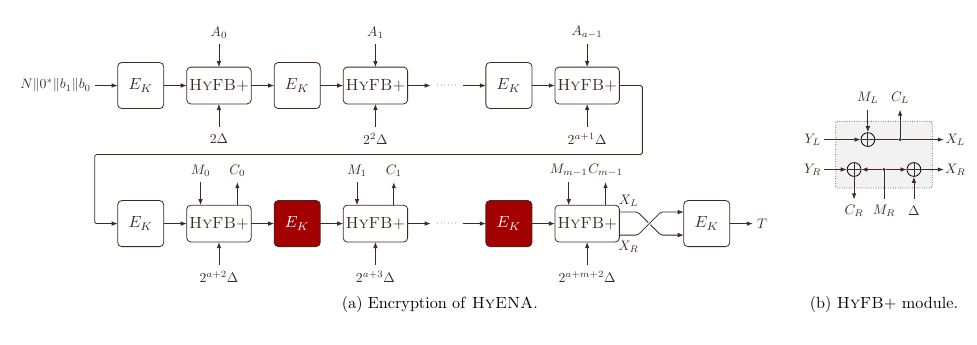
Figure 3: Overall structure of HyENA